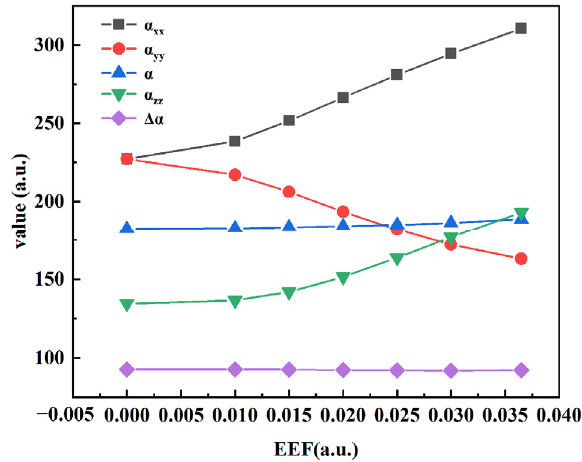
Figure 5. Properties of polarization at different EEF strengths.